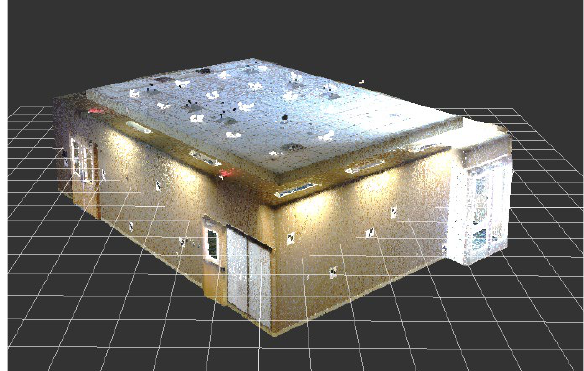
Figure 3. Point cloud of the test field with control targets This preparation step took 45 minutes.